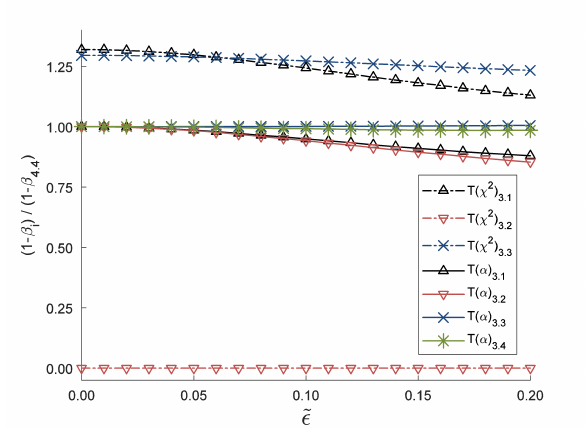
Figure 6: Power function ratios for h =10 (strong non-linearity). Dot- ted curves: using χ 2 (1) -quantiles and are denoted by T (︀ χ 2 )︀ , solid curves: using true quantiles for critical values and are denoted by T ( α )